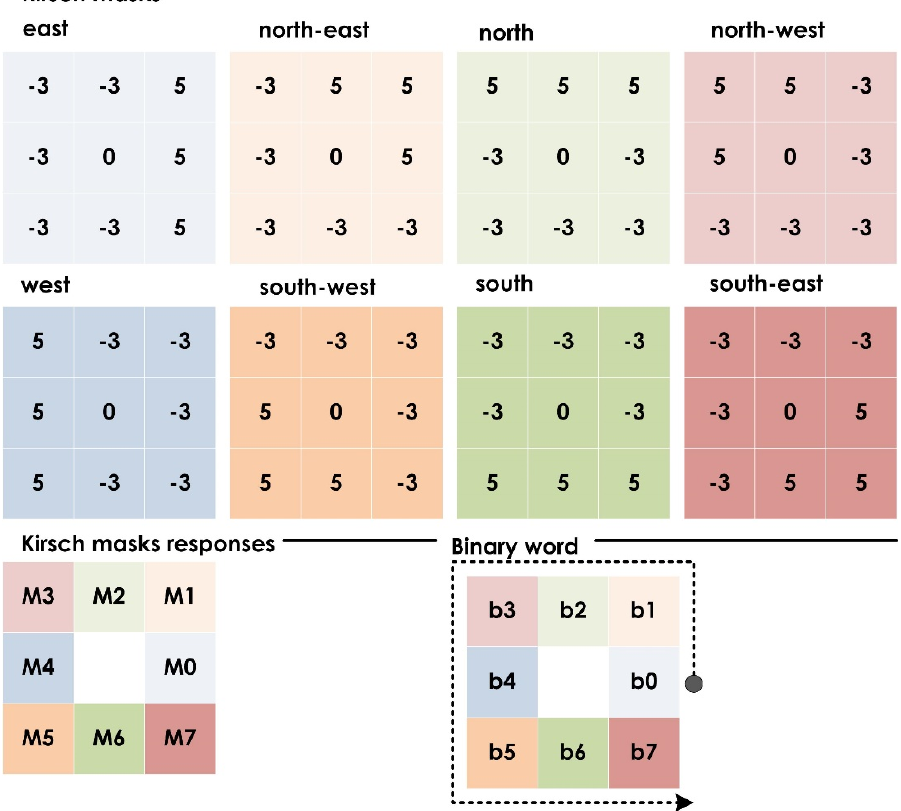
Figure 5. Computation of local directional pattern. Kirsch mask responses (M0, M1, M2, … M7) are obtained for a central pixel within the image with eight Kirsch masks that are rotated through the eight compass directions (east, north-east, north, … south-east). The neighboring pixel with the maximum Kirsch mask output determined the local direction. To form the local directional pattern, all eight neighboring pixels are sorted by the output (M0, M1, M2, … M7), and “one” and “zero” assigned to the highest and lowest four pixels, respectively (b0, b1, b2, … b7). The process is repeated throughout the image.